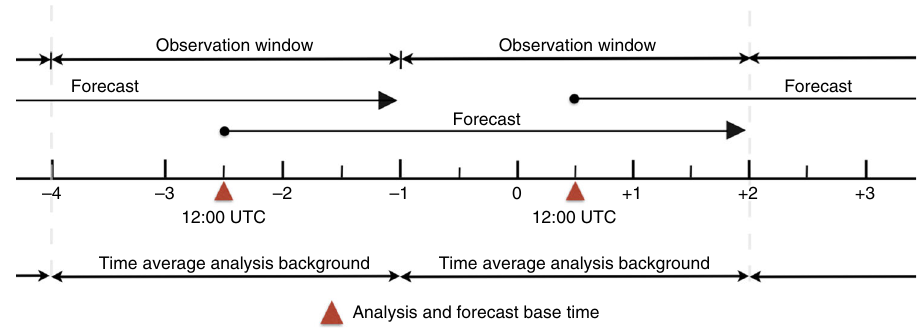
Fig. 5 Analysis-Forecast cycle and forecast error estimation scheme. The regional reanalysis systems are run using a 3-day sequential cycle with a 3-day centred observation window. To calculate the increments, a time-averaged analysis background using the last 3 days of a 4.5 day forecast in each cycle is used to be consistent with the observation window. The increments are added to the instanteous model state at the analysis and forecast base time, which is taken to be 12:00 UTC. The forecast innovation errors are based on comparing the time-averaged forecast with the forward independent super observations in the 3-day window prior to assimilation in the next cycle. Super observations reduce representativeness error as they are spatially fi ltered by model grid scale and temporally fi ltered by the